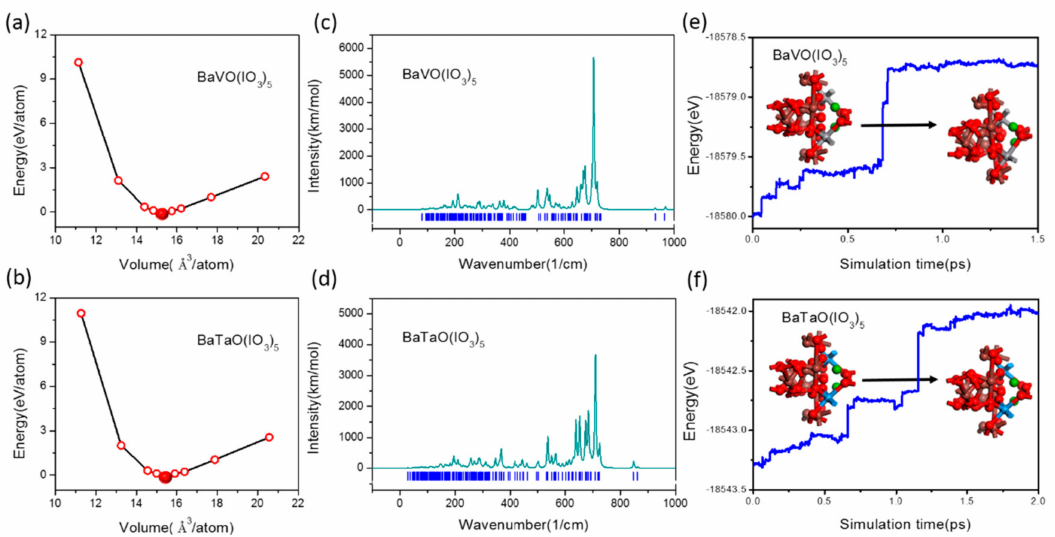
Figure 2. Evidence for the kinetic and thermodynamic stability of BaMO(IO 3 ) 5 (M = V, Ta). ( a , b ) The total energy per atom as a function of volume per atom for BaMO(IO 3 ) 5 (M = V, Ta), and ( c , d ) the lattice vibration spectra of them. ( e , f ) The energy evolution curves of the BaMO(IO 3 ) 5 (M = V, Ta) during the dynamics